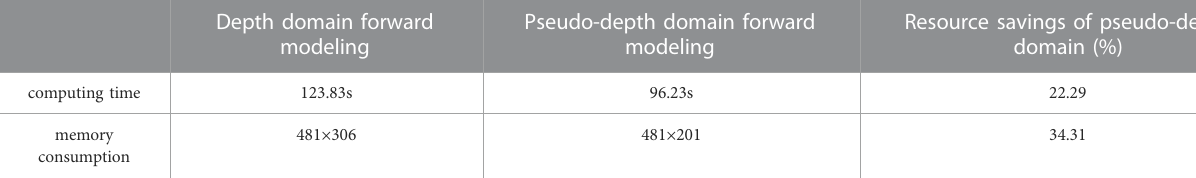
TABLE 1 Comparison of calculation ef fi ciency and memory consumption from depth domain acoustic isotropy forward method and pseudo-depth domain forward method under CPU.